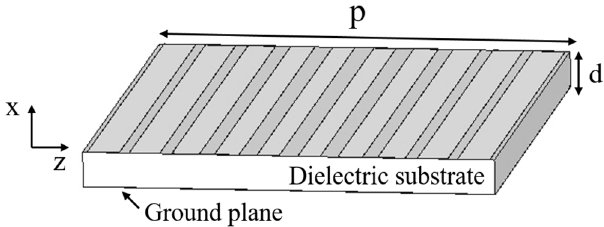
Fig. 2. A unit period of SMRS antenna composed of 10 metallic strips on a dielectric substrate over ground plane.